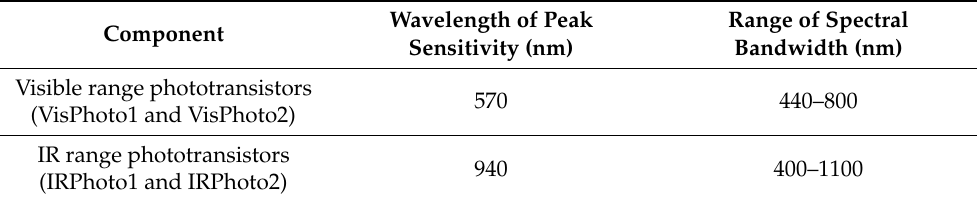
Table 2. Technical details of the D-SPARC photo-transistors.